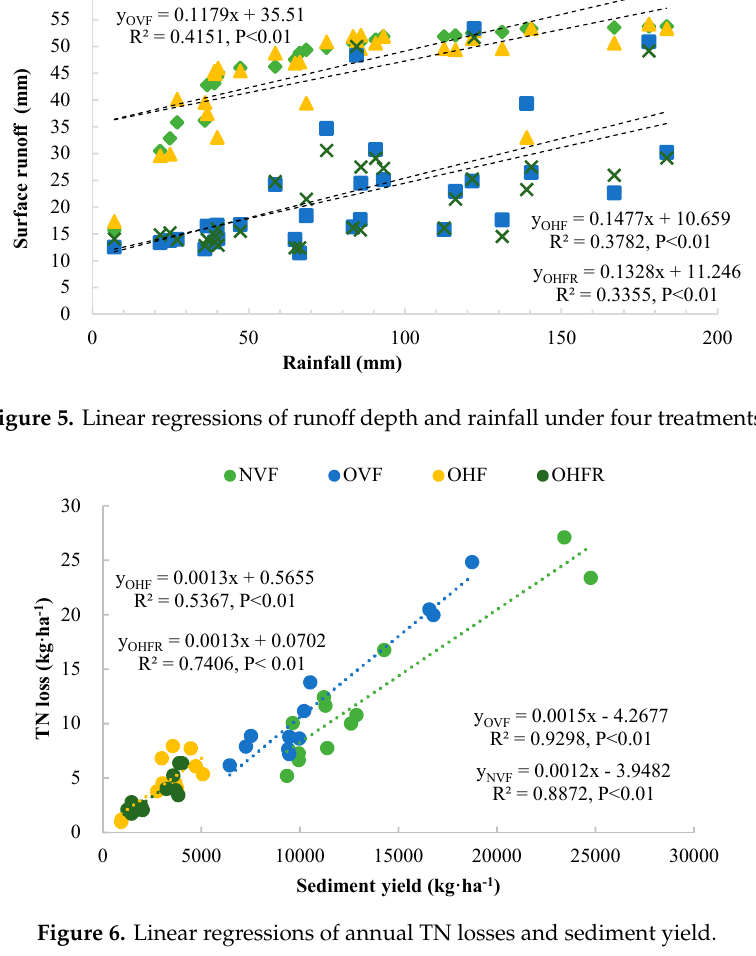
Figure 6. Linear regressions of annual TN losses and sediment yield.